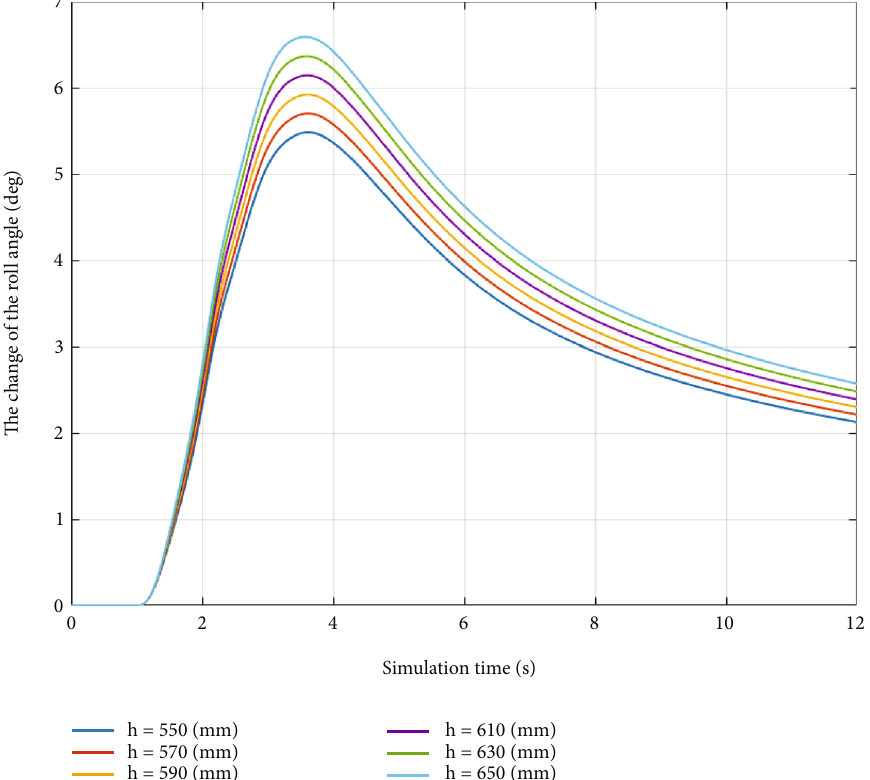
Figure 10: The change of the roll angle (the second case — distance